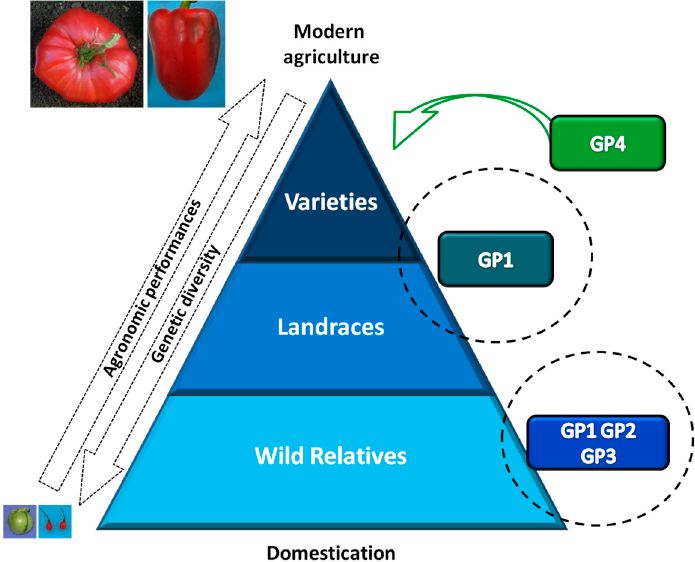
Figure 1. Global scenario from domestication to modern agriculture. Wild species of tomato and pepper ( Solanum habrochaites and Capsicum chacoense at the base of the triangle) are characterized by wide genetic variability, which can be used to improve modern varieties ( Solanum lycopersicum and Capsicum annuum , at the top of the triangle). An intermediate step of domestication is represented by landraces which have a broadening genetic variation linked to adaptation to local environments. Transfer of alleles can be possible within gene pools (GP) [33]. Four different GP levels include: (i) species with easy crossing ability resulting in fruitful hybrids and fertile off-springs (primary gene pool, GP1); (ii) less closely related species that generates weak or sterile hybrids and are characterized by difficulty in obtaining advanced generations (secondary gene pool, GP2); (iii) species requiring sophisticated techniques for gene transfer such as embryo rescue, somatic fusion, grafting, and bridge species (tertiary gene pool, GP3); and, (iv) distantly-related species belonging to different families or kingdoms for which gene transfer is not possible sexually but through direct gene transfer by means of genetic engineering (fourth gene pool, GP4).